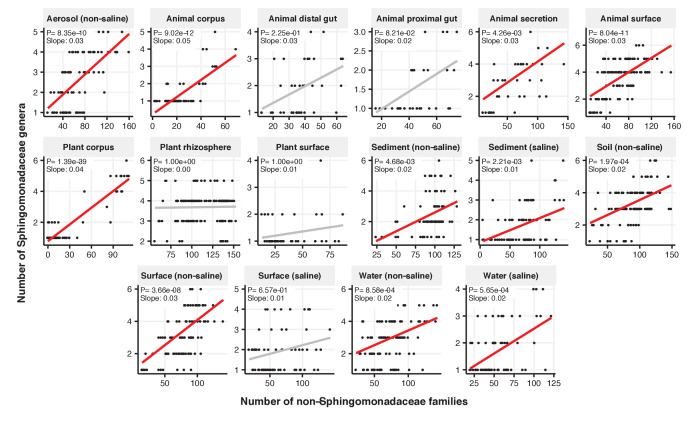
Focal-lineage diversity as a function of community diversity across biomes in Sphingomonadaceae.Linear models are shown for genera per family (y-axis) as a function of community diversity (non-focal families, x-axis) in each of the 17 environments (EMPO3 biomes). Only environments containing the focal lineage are shown. Significant positive diversity slopes are shown in red (linear models, p<0.05, Bonferroni corrected for 17 tests), and non-significant in grey.